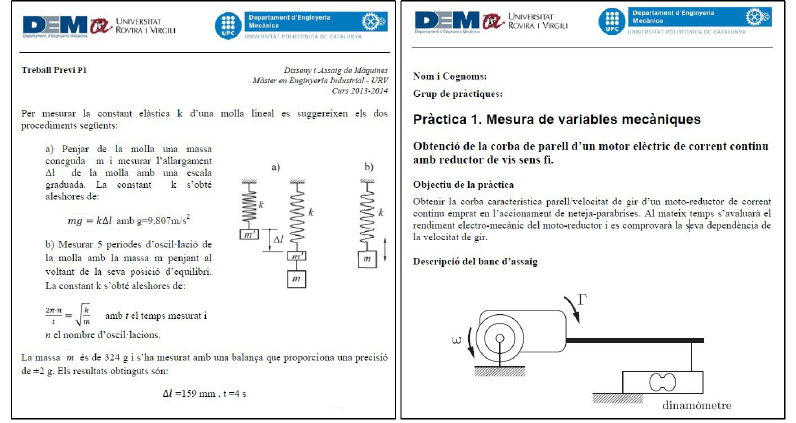
Figure 2. Documents used during the actvity conducted as a pilot experience, available within the Google+